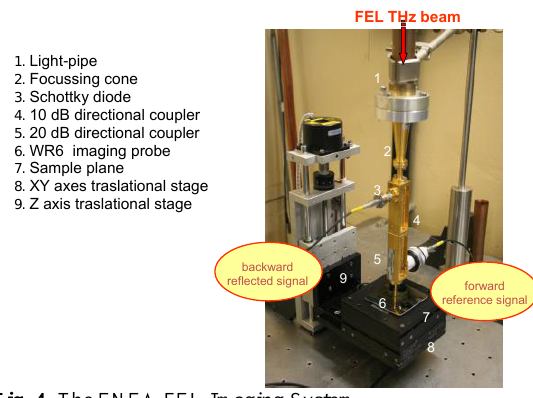
Fig. 4. The ENEA FEL Imaging System